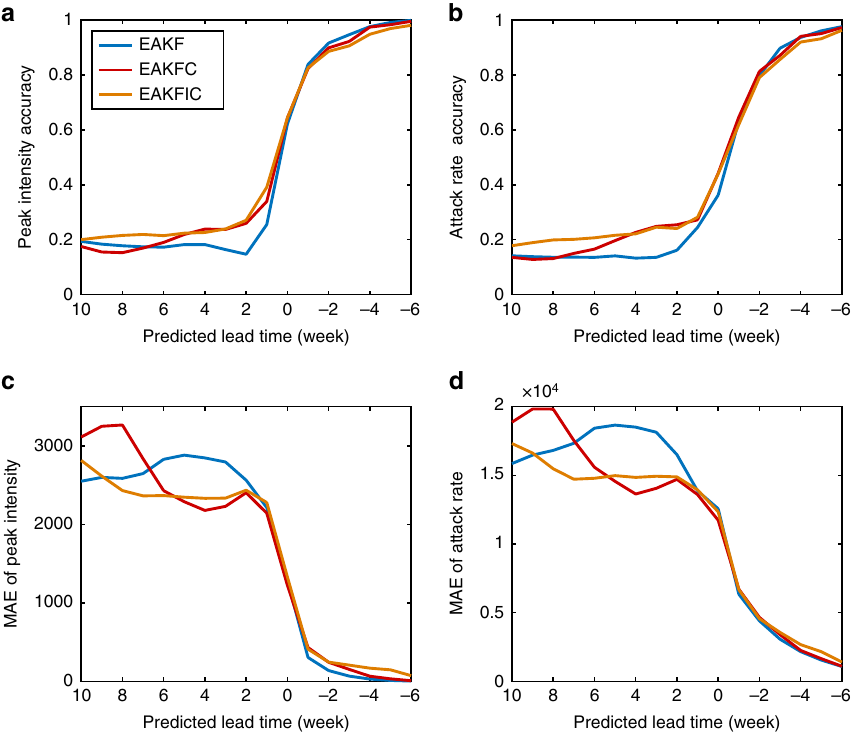
Fig. 3 Prediction accuracy of peak intensity and attack rate. Results are averaged for 95 cities in the United States for the 2003 – 2004 through 2013 – 2014 seasons excluding the 2008 – 2009 and 2009 – 2010 pandemic seasons. For each city and season, 100 independent predictions with 300 ensemble members were generated weekly. a , b Percentage of ensemble predictions whose predicted values lie within the ± 25% interval of observed peak intensity and attack rate. c , d MAE of ensemble predictions of peak intensity and attack rate. Predicted peak is de fi ned as the peak magnitude of the ensemble mean